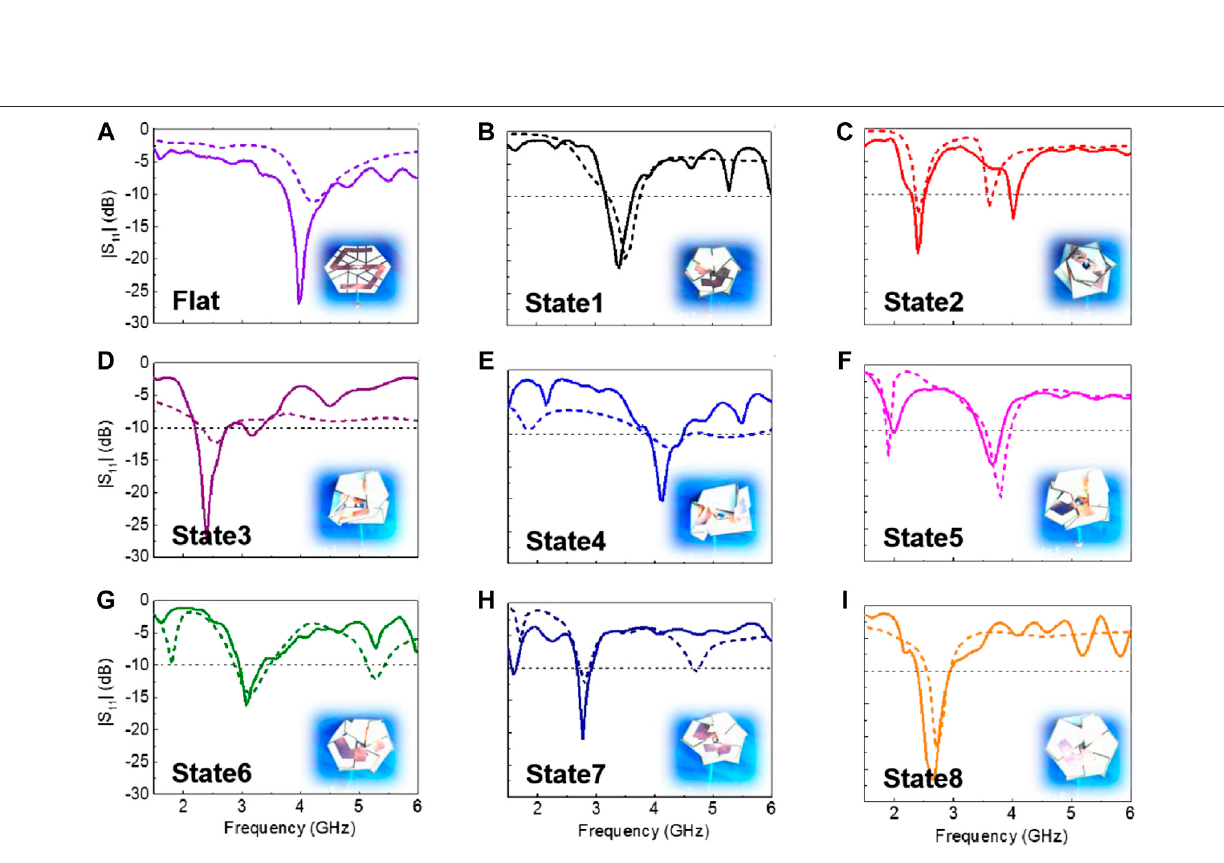
Frontiers in Materials |